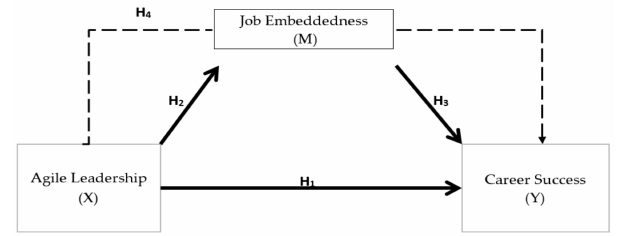
Figure 1. Research